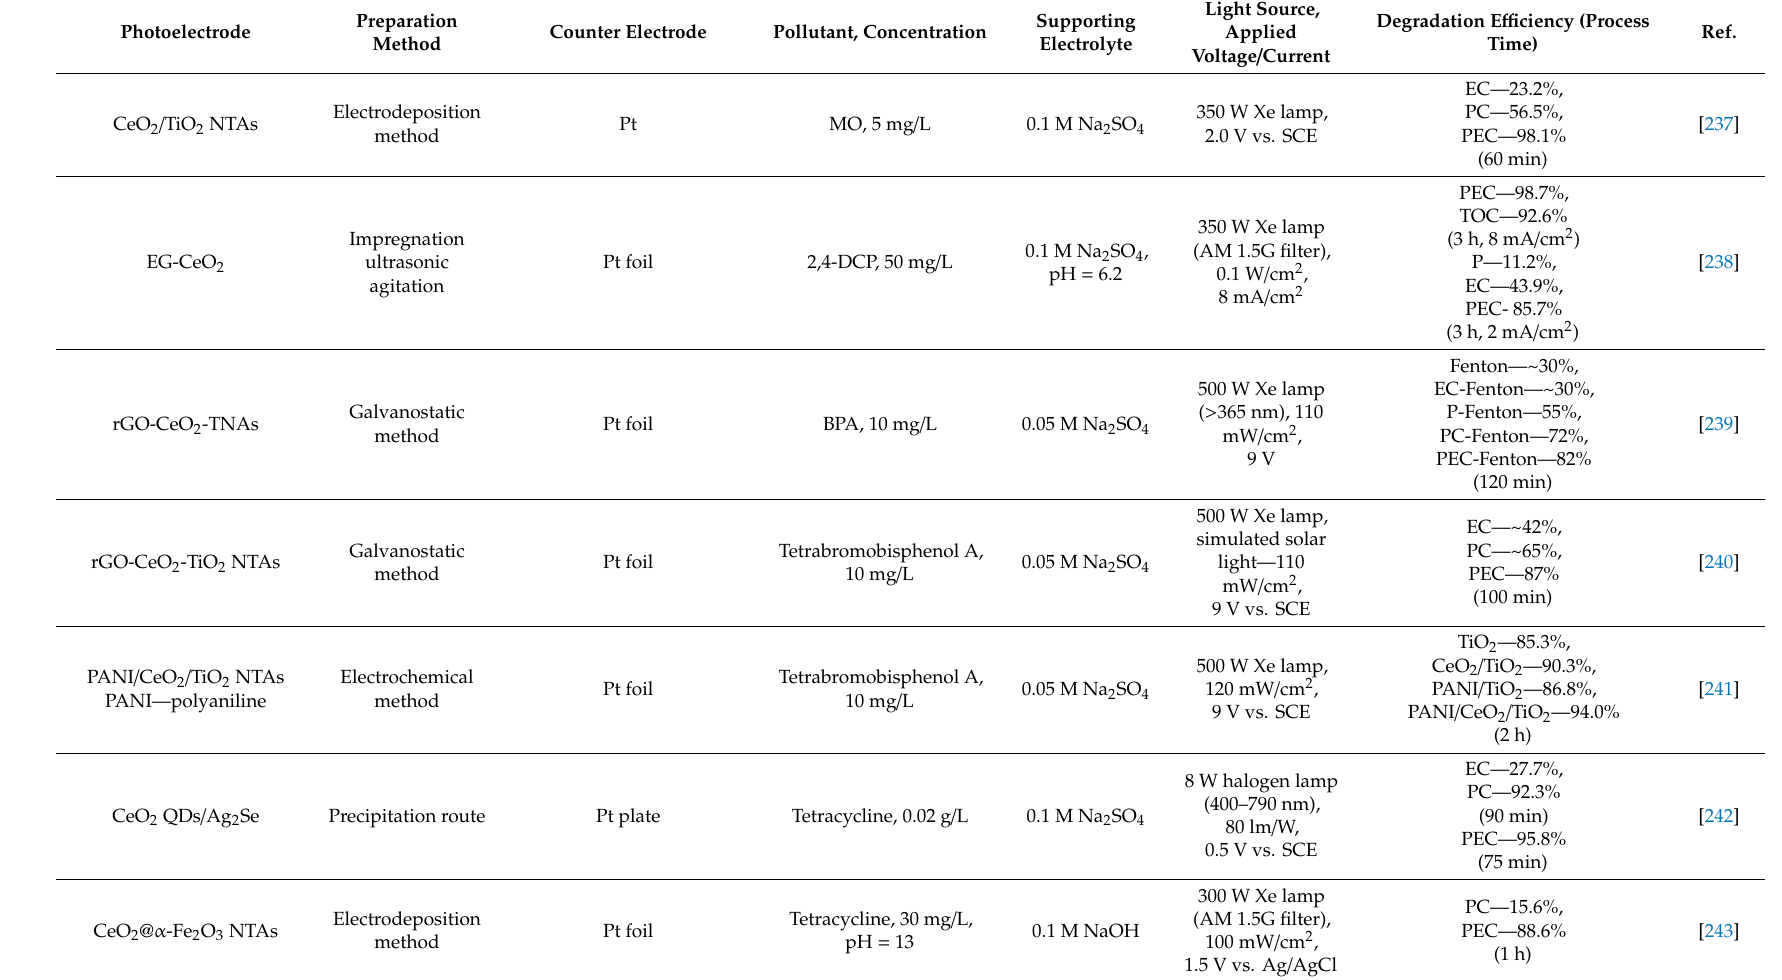
Table 6. Application of CeO 2 composites as photoelectrodes in photoelectrocatalytic (PEC)